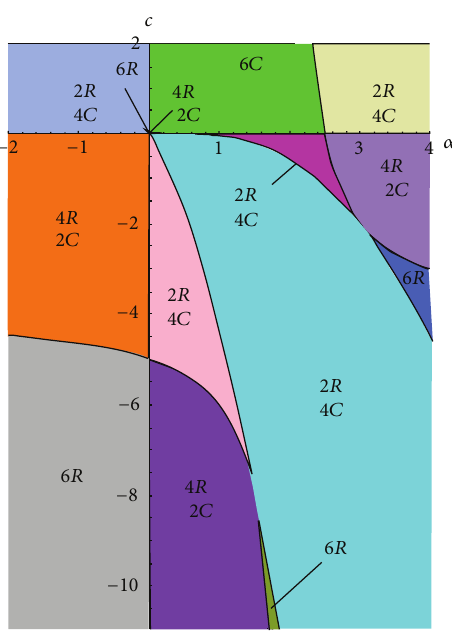
Figure 2: Bifurcation curves of fixed